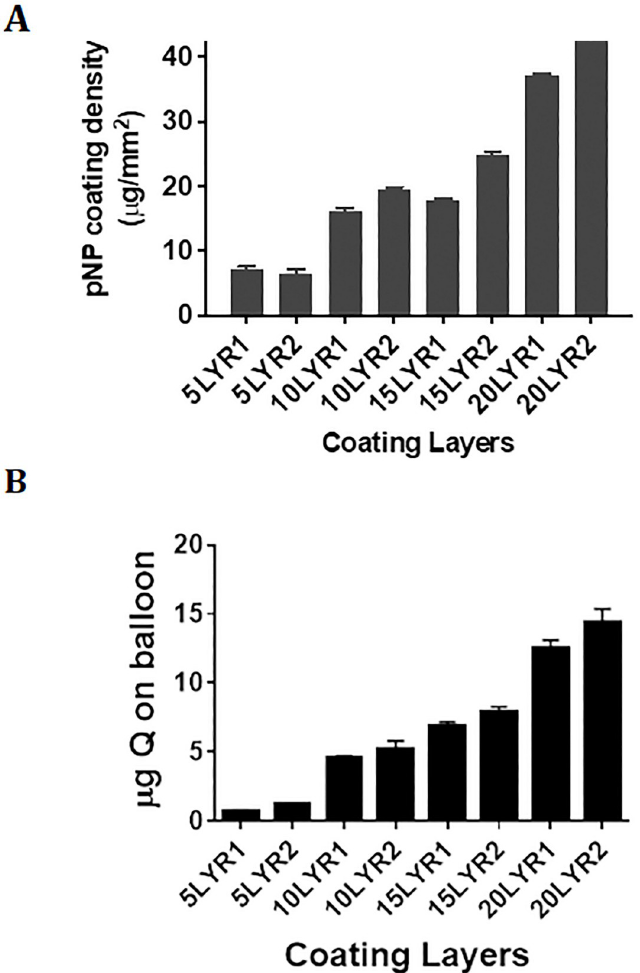
Fig 11. Amount of quercetin (Q) and quercetin nanoparticles (pNPs) in balloon coating. A) pNPs were eluted from the balloons using organic solvent and pNP load was determined gravimetrically. Total loading in μ g was normalized to balloon areas. Data represent means ± SD for 5 measures per balloon. B) pNPs were eluted from the balloons using organic solvent and the Q content was determined using HPLC. Data represent means ± SD for n = 3–4 replicate